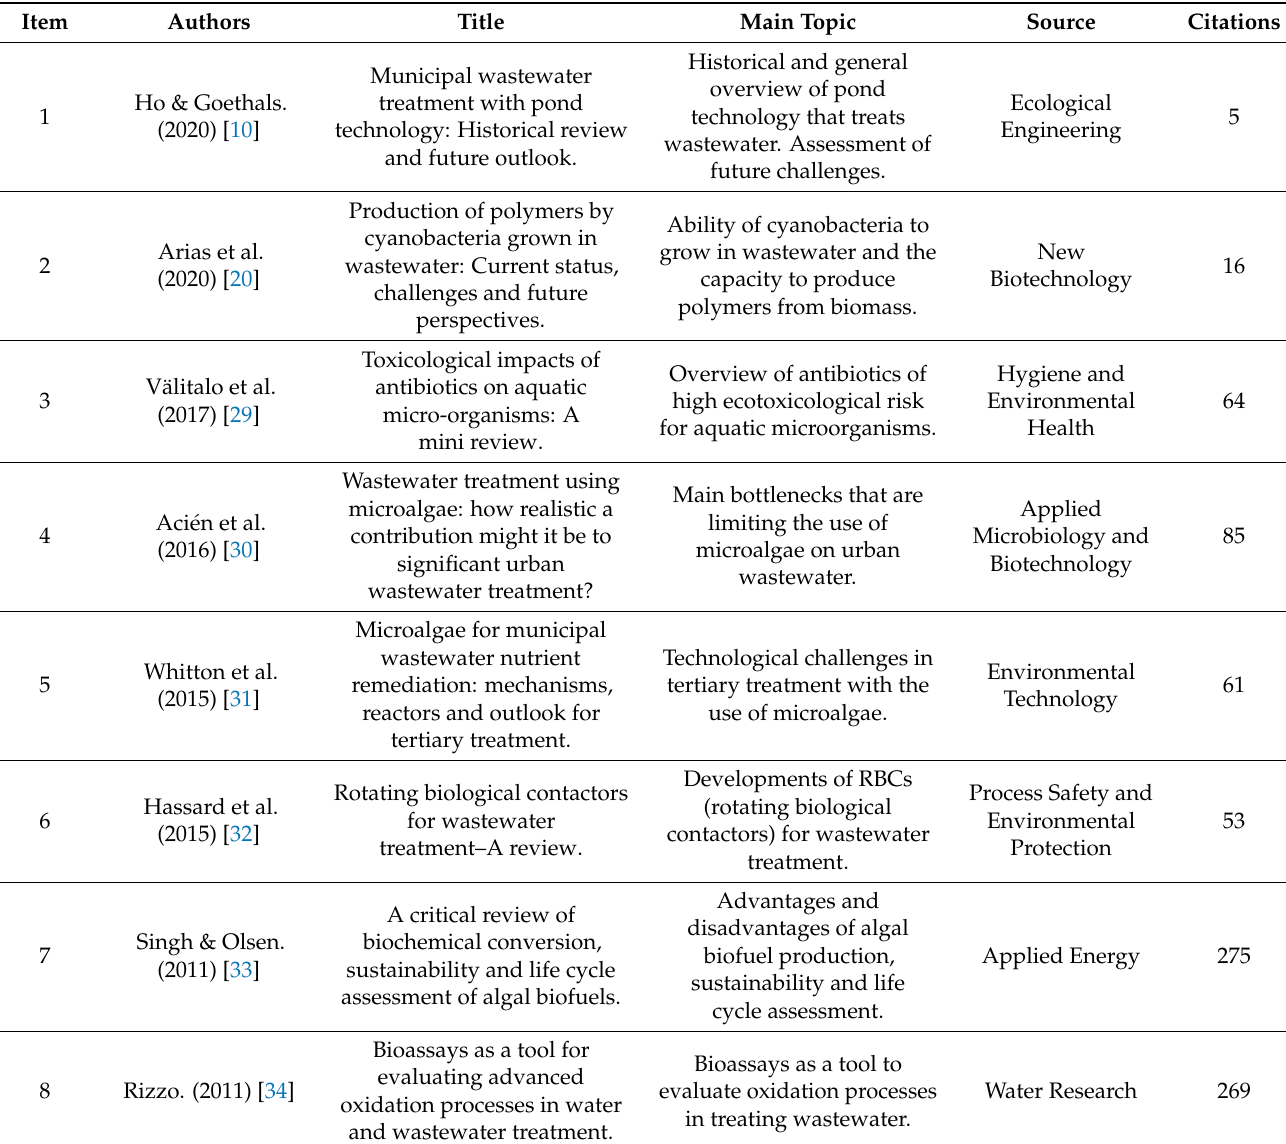
Table S2 (primary wastewaters); Table S3 (secondary wastewaters); Table S4 (wastewaters mixed with other substrates) and Table S5 (nonspecified urban wastewaters). Table 1. Outline of “Review” items regarding microalgae on